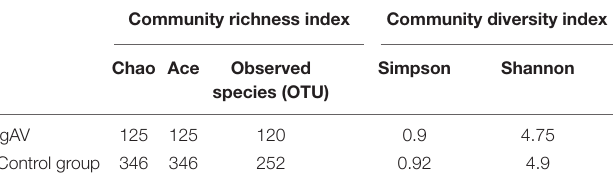
TABLE 1 | Comparison of the α -diversity between the groups.